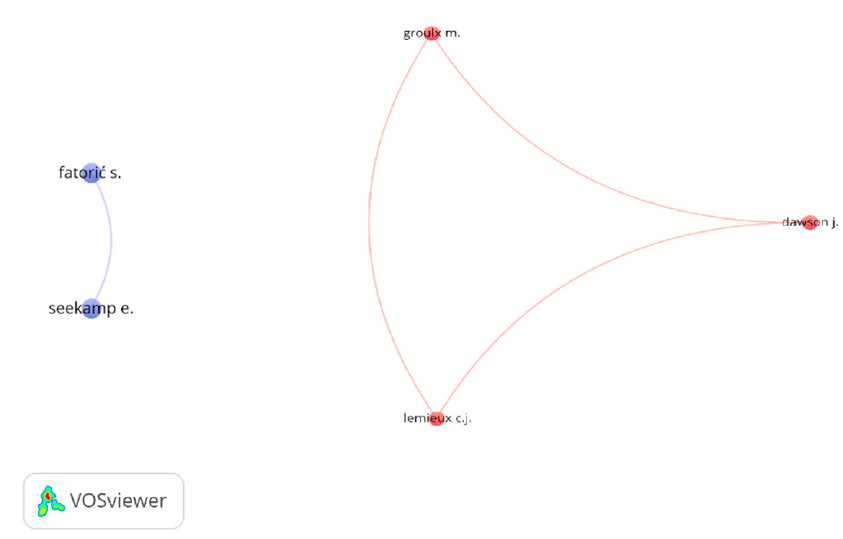
Figure 6. Most productive co-author network. Source: own elaboration.